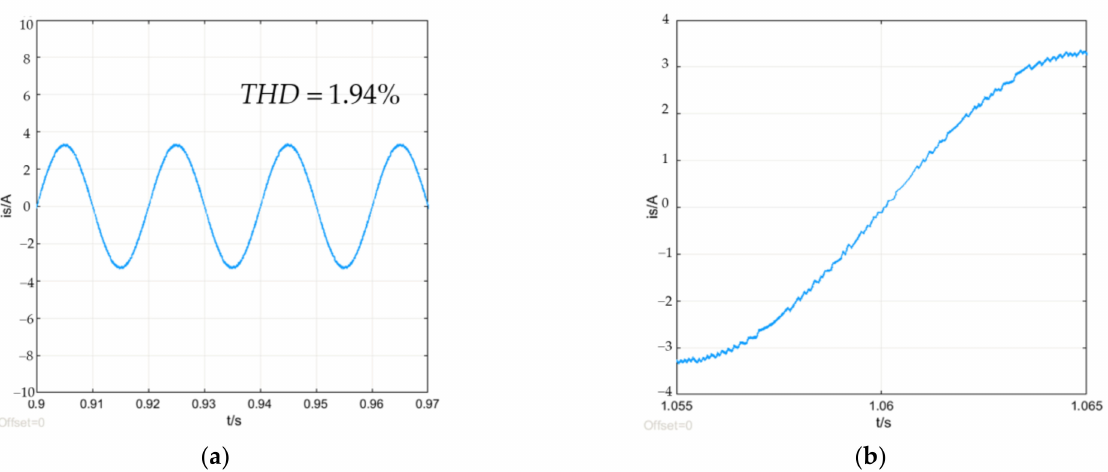
Figure 13. The simulated current waveform when the dead-time is 6 µ s and there is dead-time compensation. ( a ) The full cycle waveform of the current; ( b ) The waveform when the current crosses